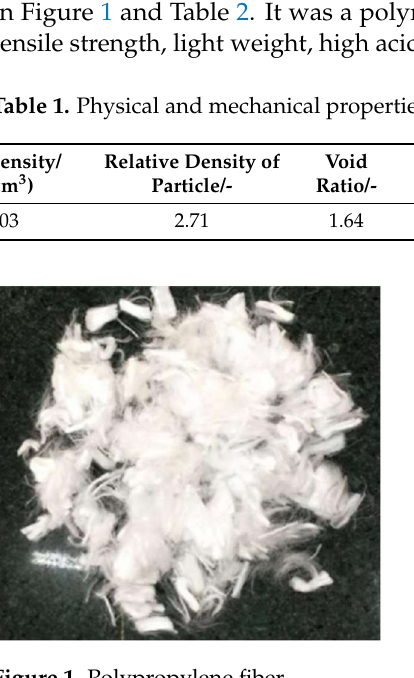
Table 1. Physical and mechanical properties of silty soil in Nansha District, Guangzhou.